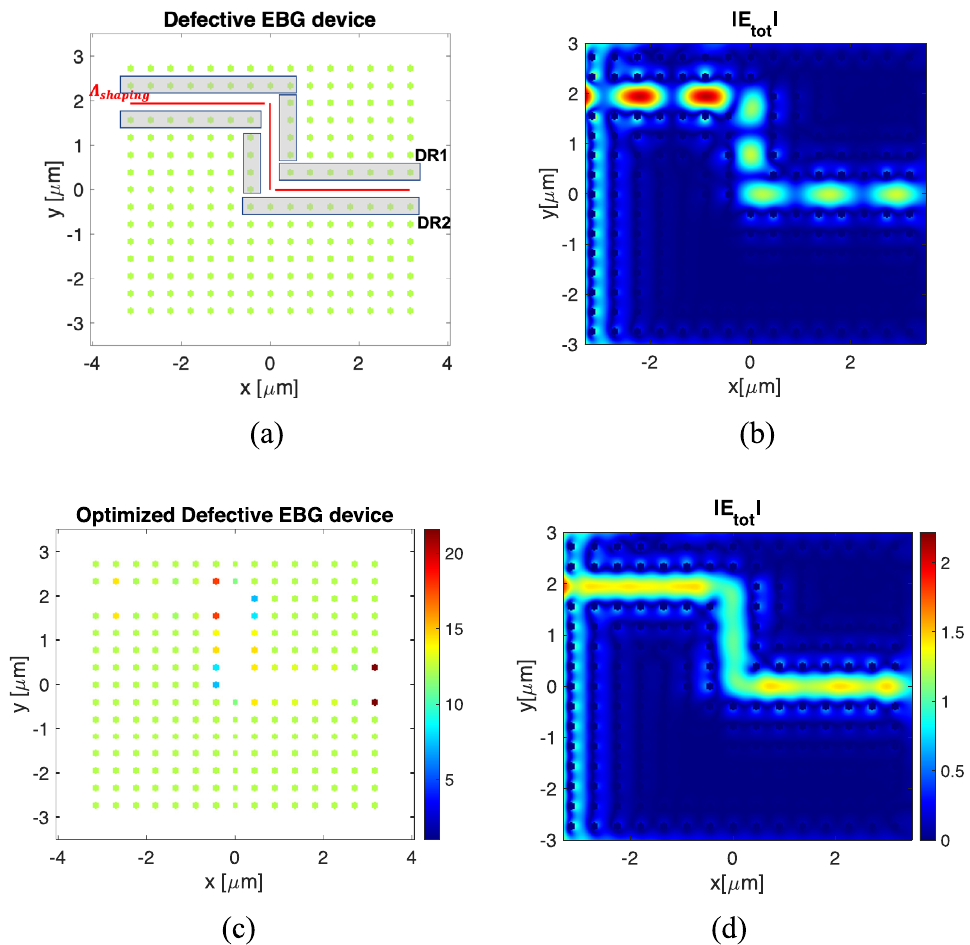
Fig. 5. Optimization of a double 90 ° bend waveguide. (a) Permittivity map of the defective EBG device where the DR is superimposed with light grey rectangle and (b) the corresponding electric fi eld amplitude distribution. (c) and (d) the same as (a) and (b) but for the optimized EBG device through the I-SMM [ e opt =12.2,14.3,12.2,12.5,11.9,12.5,17.7,11.3,12.4,7.4,8.3,13.7,14.4,14.2,12.9,13.2,12.8,12.9, 11.8,21.6].